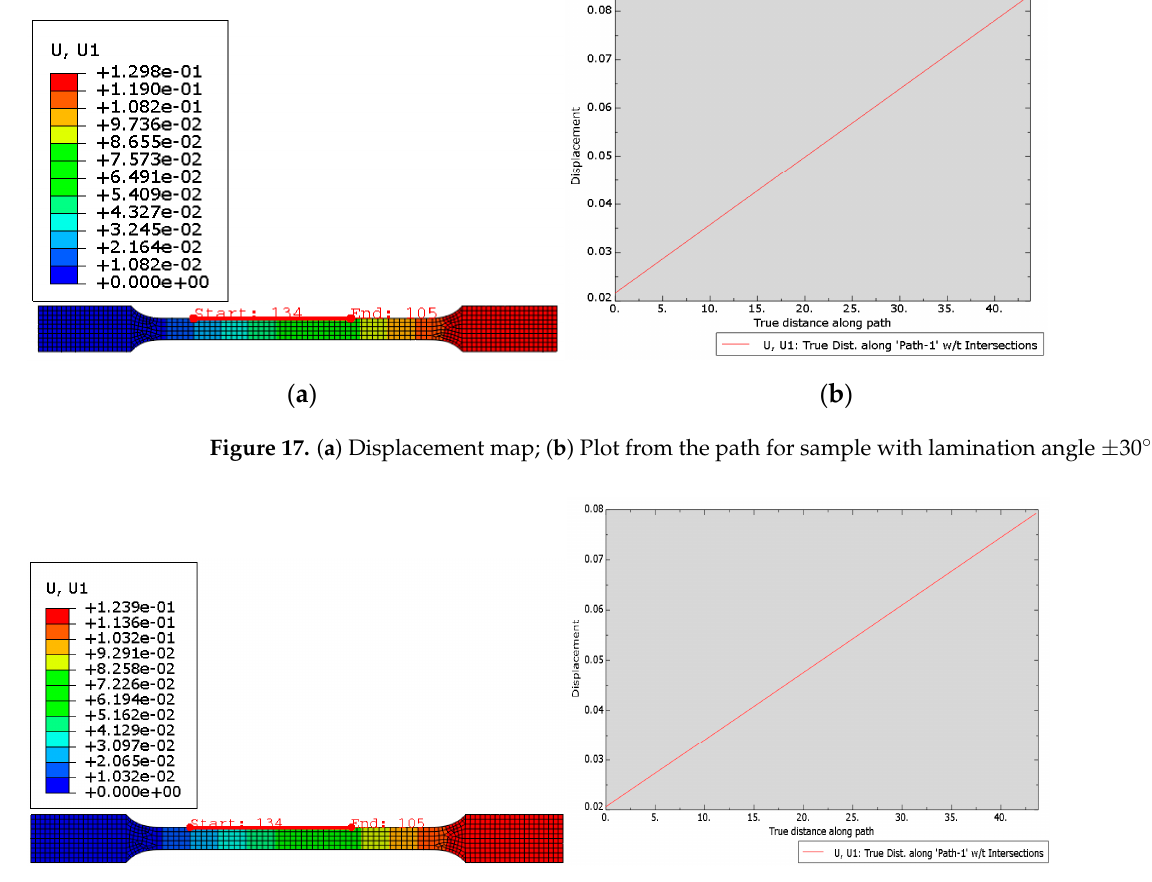
Table 9. Results for the sample with lamination angles ±30 (cid:3042) .